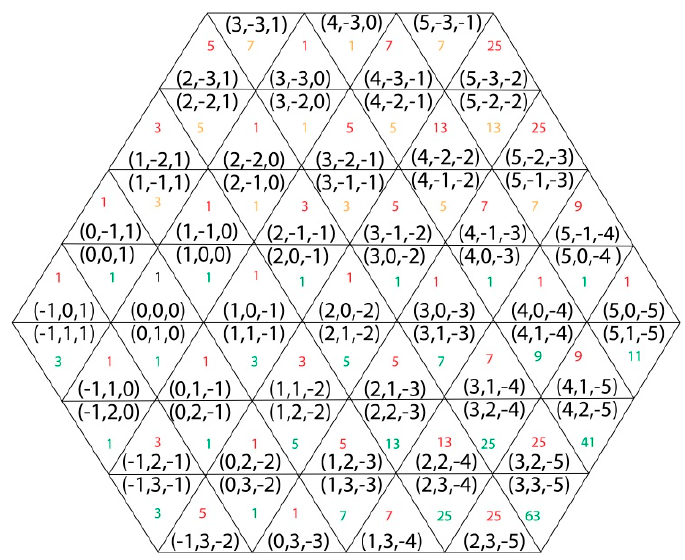
Figure 7. The number of shortest weighed paths from trixel (0,0,0) to all other displayed trixels in the case of 2 α < β and 3 α = γ .